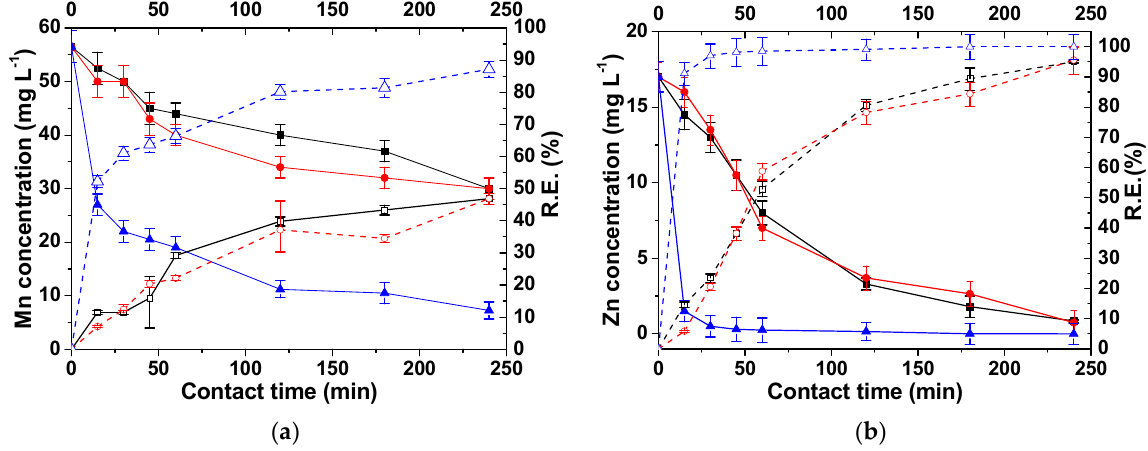
Figure 4. Influence of the Cyprinus carpio scale grain sizes on the residual concentrations and removal efficiency of Mn ( a ) and Zn ( b ) ions from AMD solution after various contact times. Fish scale grain size: ( ■, □ ) raw (as received); (●, ○ ) fine; and ( ▲, Δ ) powder. (−−−−) Residual concentration data. (- - - -) Removal efficiency data.